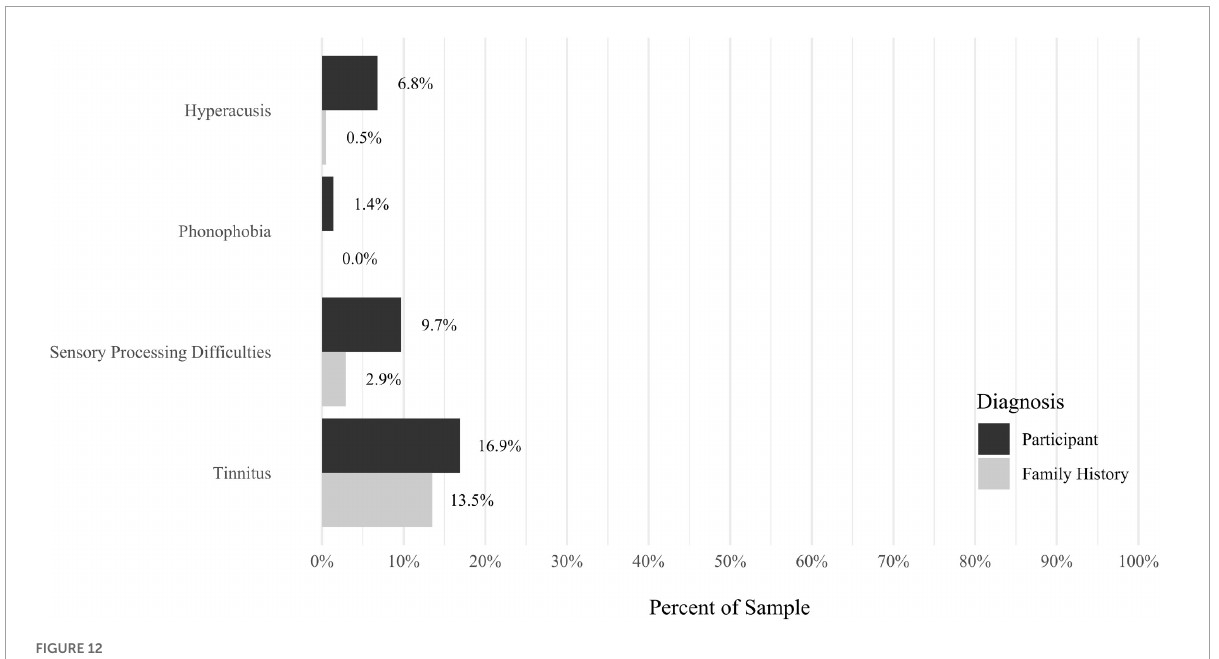
FIGURE12 Rates of medical health problems: sensory processing difficulties.